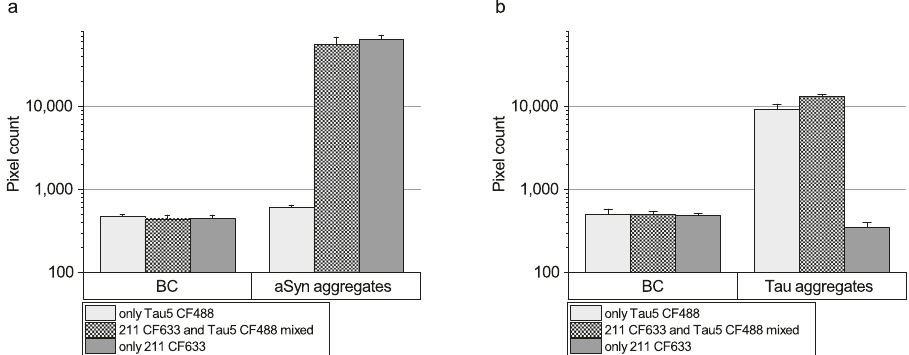
Fig. 6 Analysis of probe interference. To analyze the effect of detection probe interference on the signal, we performed an additional experiment in which we added either only one detection antibody or both detection antibodies. Using only the relevant antibody probe did not show an increased pixel count for the detection of aggregated aSyn ( a , 211 CF633) or Tau ( b , Tau5 CF488), respectively. Standard deviation was calculated from the four